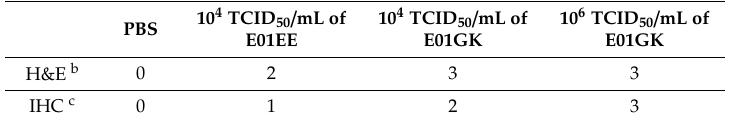
Table 2. Histopathological and immunohistochemistry scoring of the lesions and viral antigens from mouse lung tissue a at 15 d.p.i.